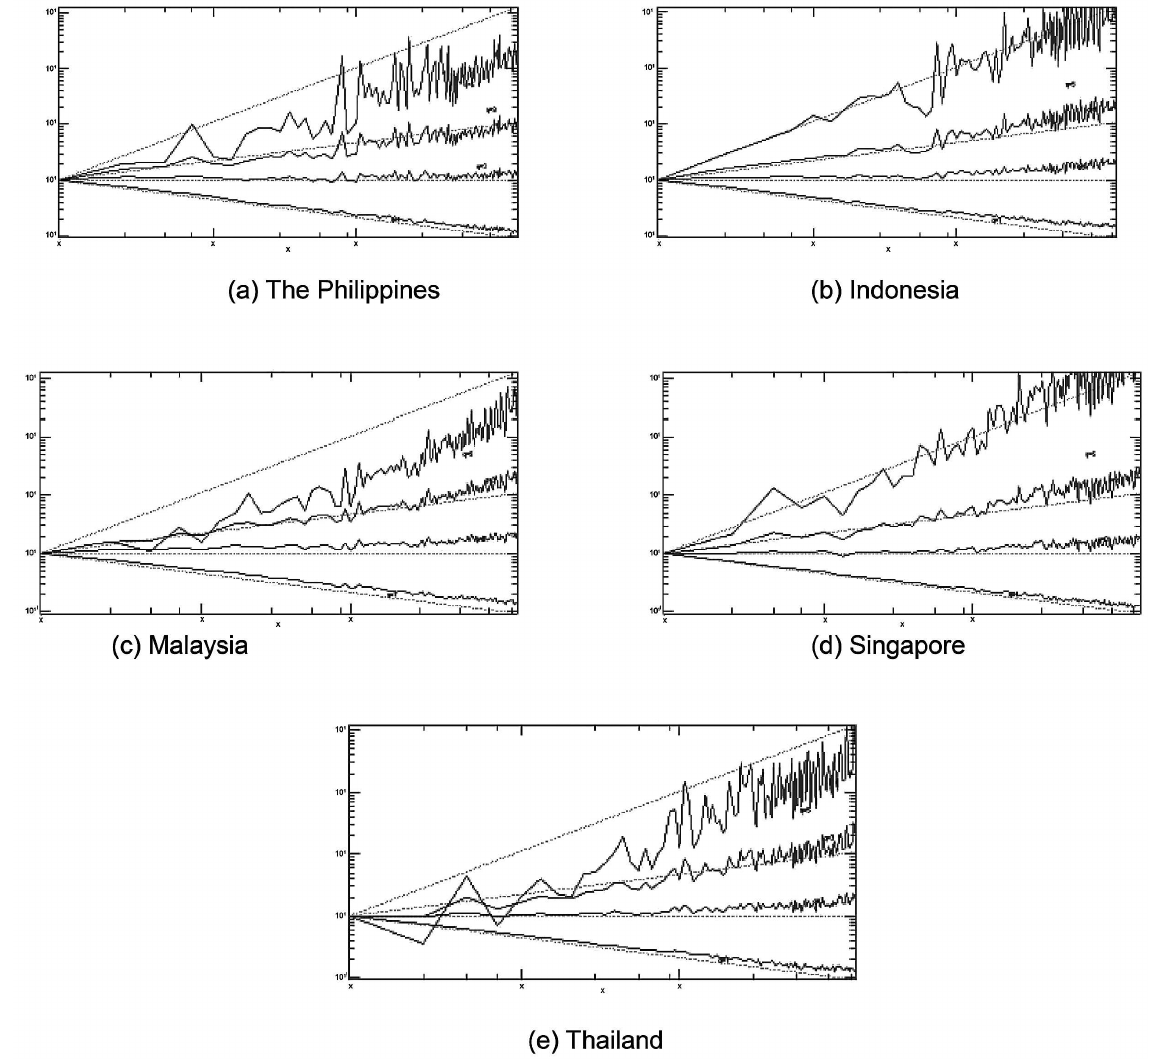
Figure 3. Partition function each country parallel with the horizontal axis on range